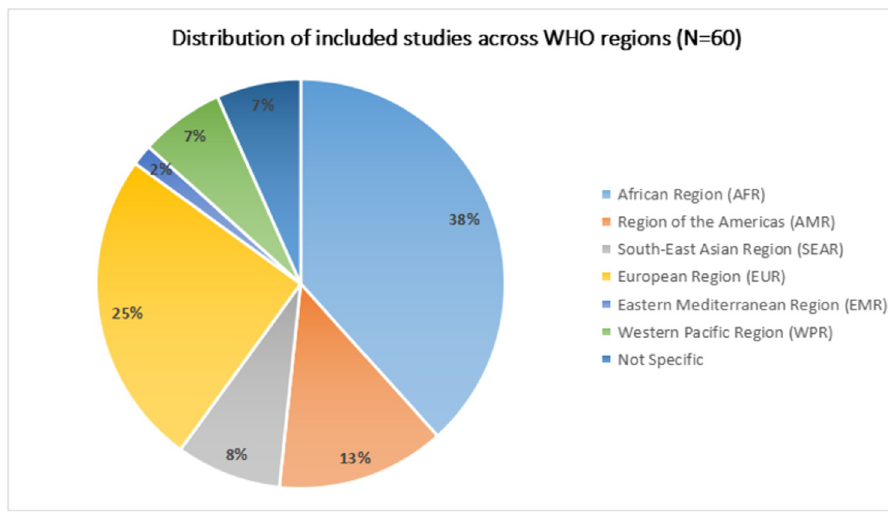
Fig 3. Distribution of included studies across WHO